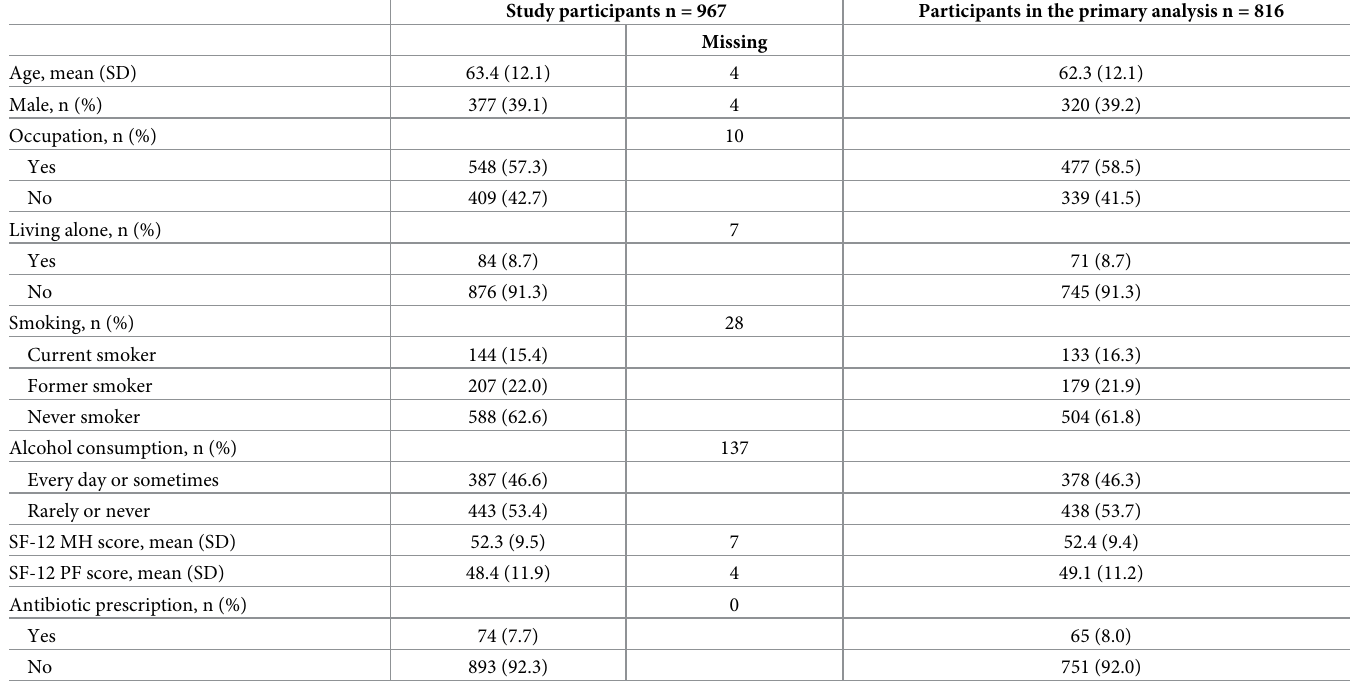
Table 1. Characteristics of study participants.